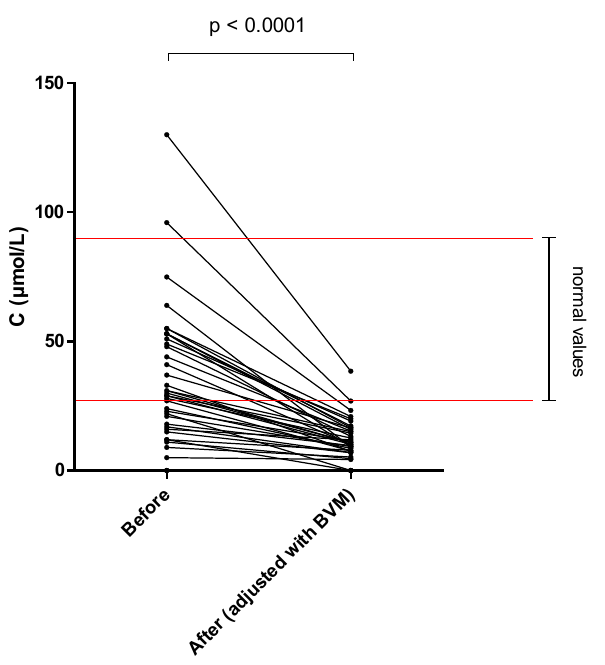
Figure 6. Vitamin C (ascorbic acid) blood concentration before and after one 4 h-HDF session (paired t- test).